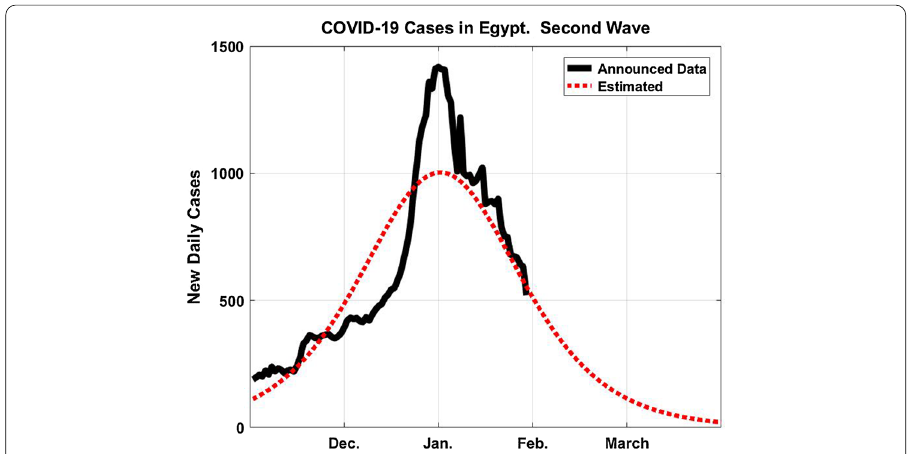
Fig. 5 The daily COVID‑19 cases in Egypt in the second wave assuming P